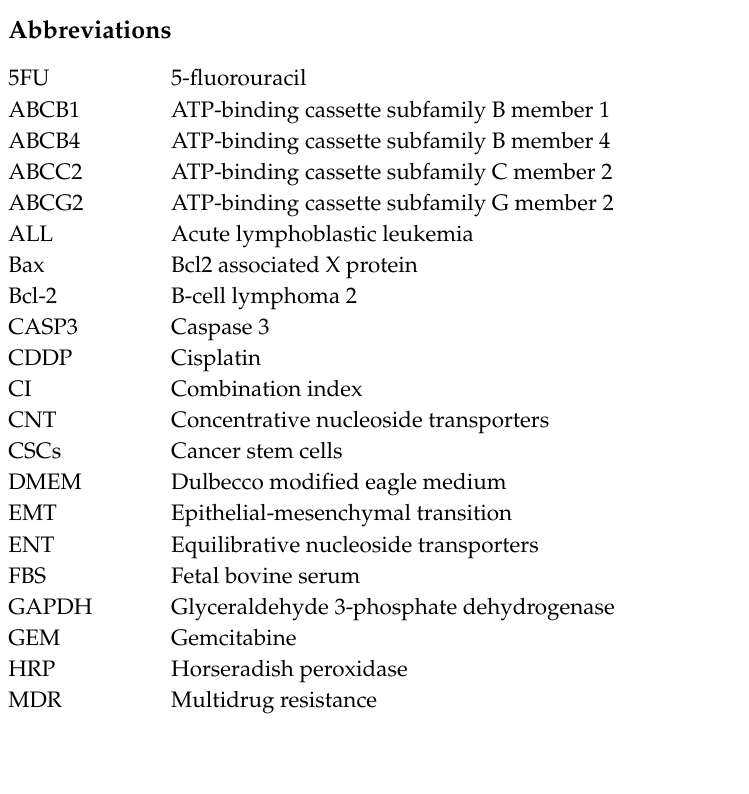
Supplementary Materials: The following are available online, Table S1: List of primers used in this study,